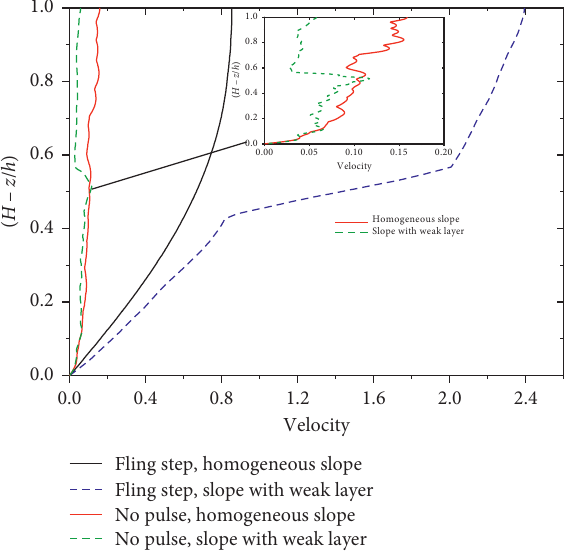
Figure 13: Comparison of analytical solutions of pulse-like and pulseless ground motions.